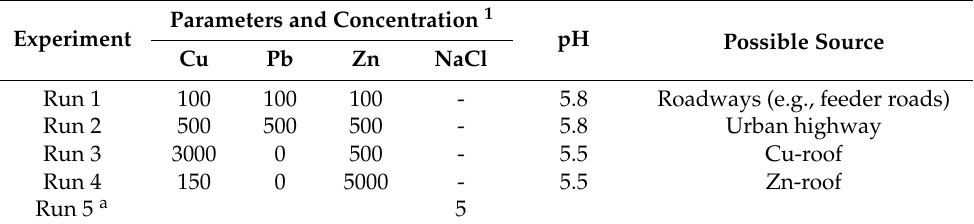
Table 2. Influent concentrations of heavy metals ( µ g/L) and NaCl (g/L) in different experimental runs and influent